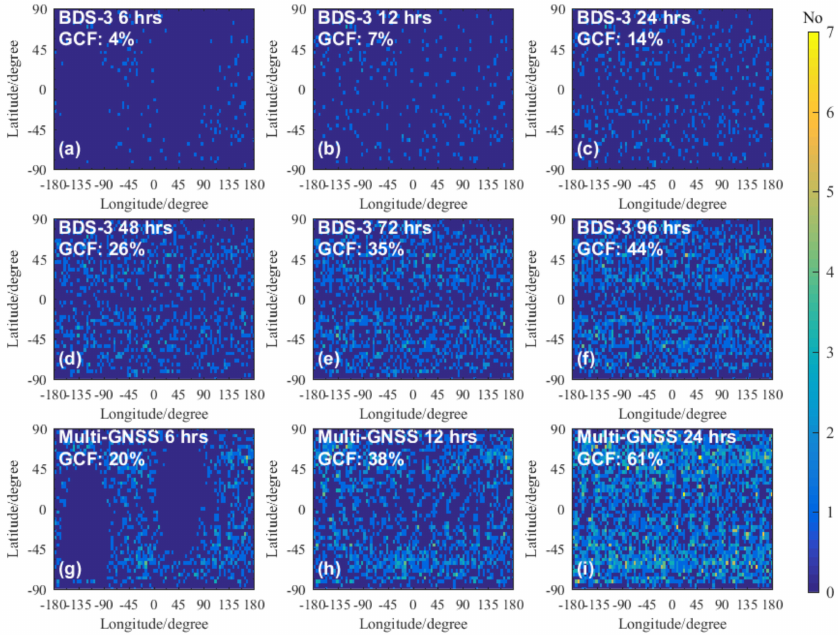
Figure 3. The global coverage of GNSS RO events for MET/BDS − 3 and MET/multi − GNSS RO systems, illustrating the number of RO event revisits using a 4 ◦ × 4 ◦ latitude and longitude grid coordinate.